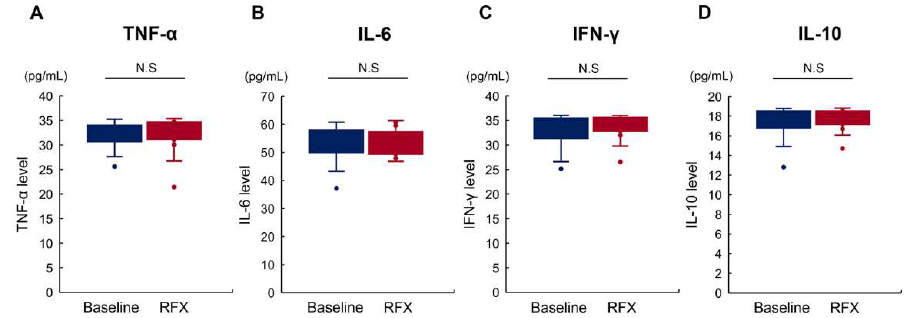
Figure 5. Effect of rifaximin in serum levels of proinflammatory cytokines. Rifaximin did not affect the serum levels of proinflammatory cytokines, including tumor necrosis factor (TNF)-α ( A ), interleukin (IL)-6 ( B ), interferon (IFN)-γ ( C ), and IL-10 ( D ).